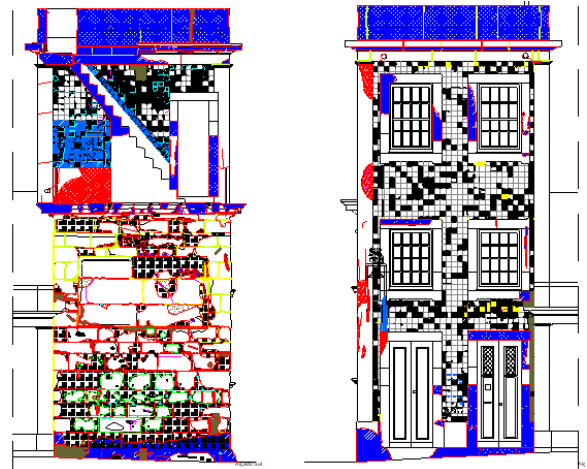
Figure 10. Facades of the São Miguel – o – Anjo lighthouse, in Porto. Mapping of the materials and anomalies, based on the photogrammetric survey (Genin,